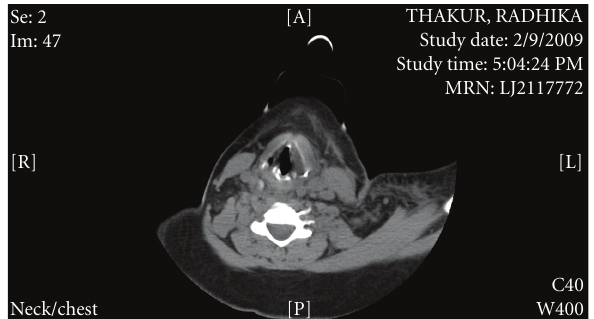
Figure 1: CT Neck showing the abscess.